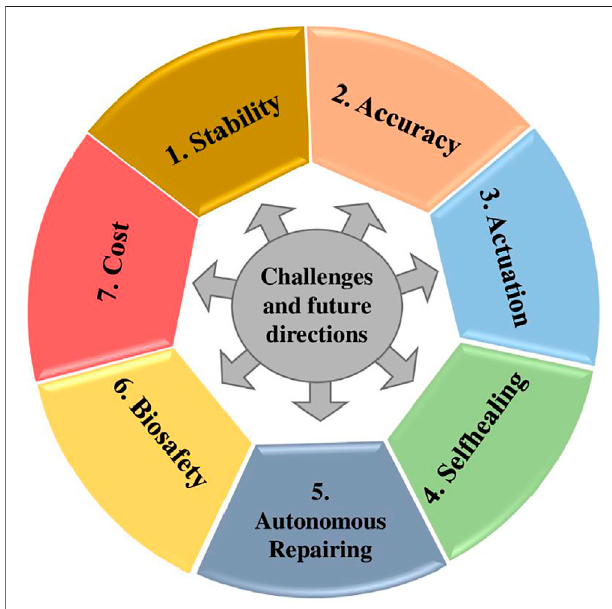
FIGURE 7 | Challenges and future